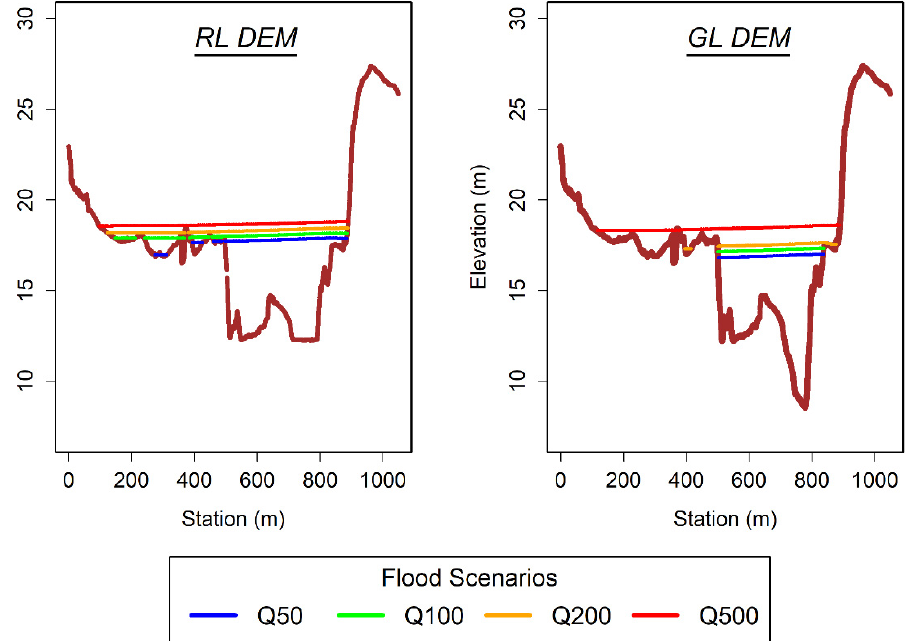
Figure 8. The water surface elevations for the flood levels Q50, Q100, Q200, and Q500 years for a cross-section in the Gaula site, using the different LiDAR DEMs.